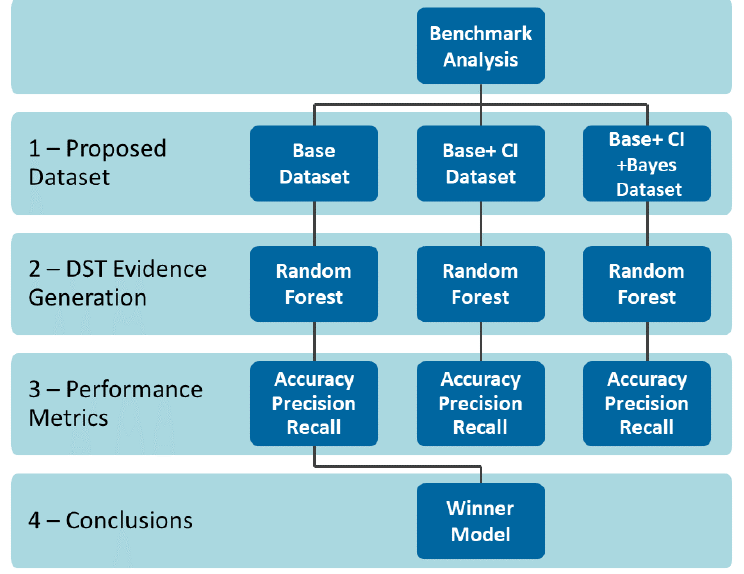
Figure 9. Benchmark method.